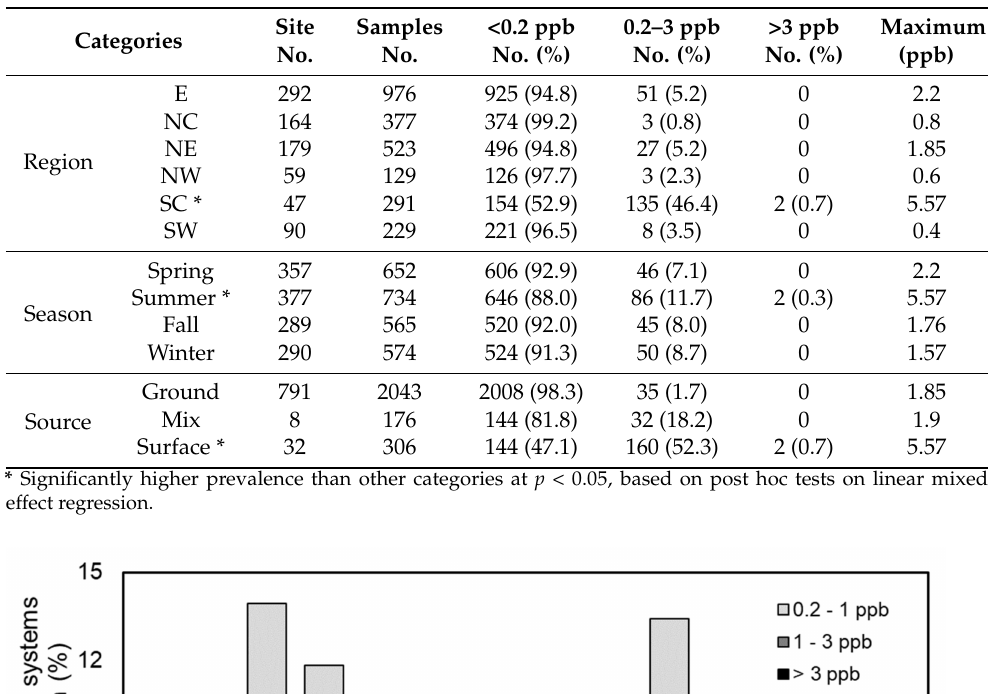
Table 4. Occurrence of Atrazine in Public Water Systems (Drinking Water MCL = 3 ppb).